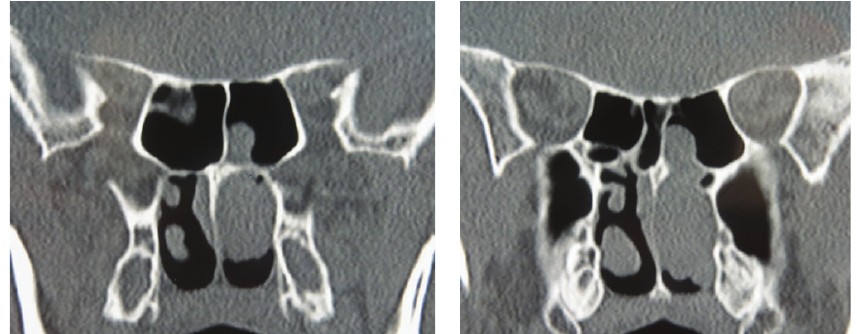
Figure 1: Preoperative